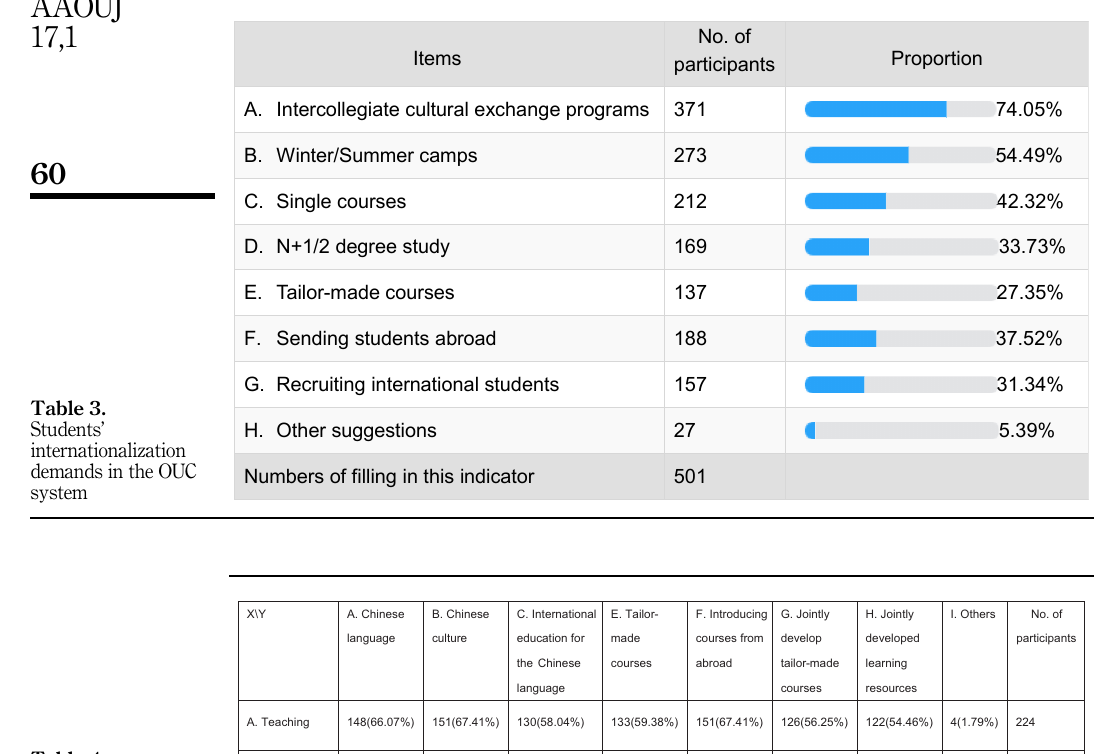
Table 4. Learning resources ’ internationalization demands in the OUC